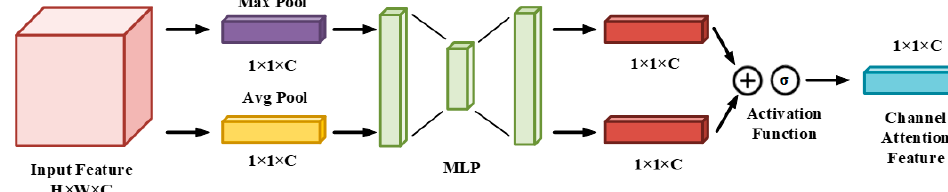
Figure 6. Channel attention module.